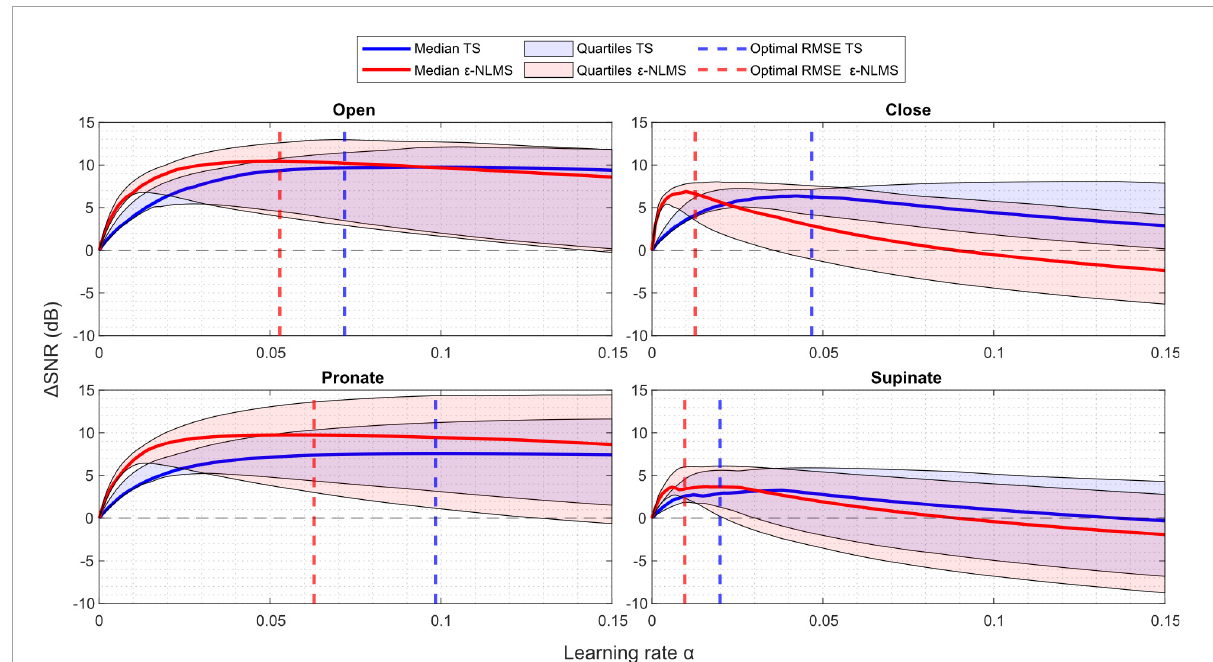
FIGURE4 (cid:49) SNR increased with an increasing learning rate α to a point, after which further increases in the learning rate worsened the change. The sensitivity of both Template Subtraction (TS) (blue) and ε -Normalized Least Mean Squares ( ε -NLMS) (red) showed similar trends. Higher learning rates α led to increased variability (shaded regions), but the α determined by the parameter optimization (dashed vertical lines) provided a good balance between median performance and